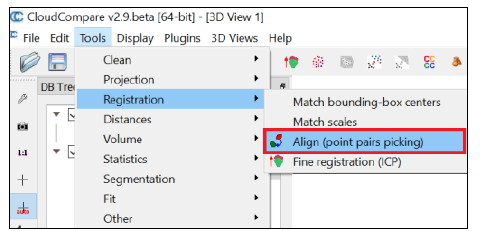
Figure 36. Align (point pairs picking) menu